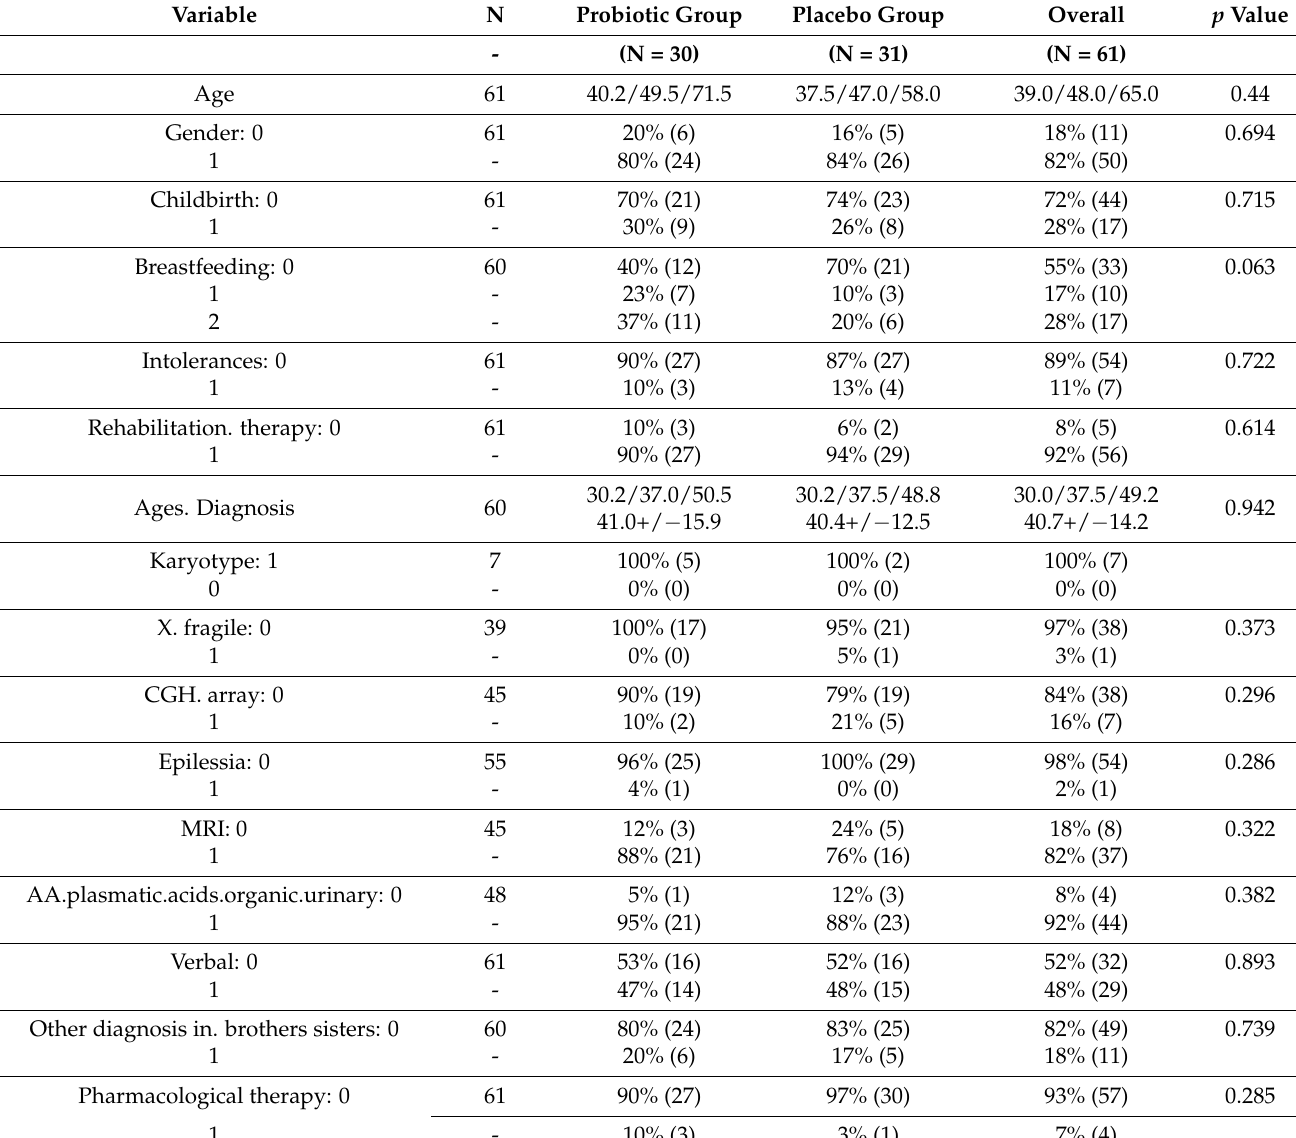
Table 1. Descriptive statistics. Continuous data are reported as the median (I, III quartiles); categorical data are reported as a percentage and absolute frequencies. Wilcoxon-type tests were performed for continuous variables, and the Pearson chi-squared test or Fisher’s exact test were conducted for categorical variables, wherever